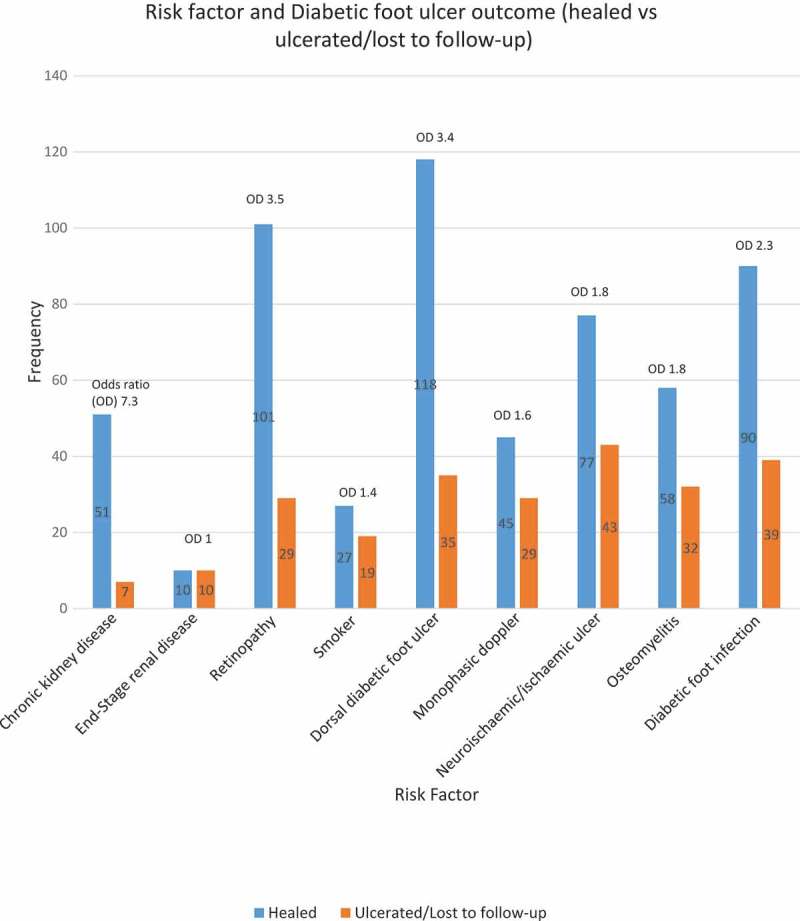
Risk factors and outcome.